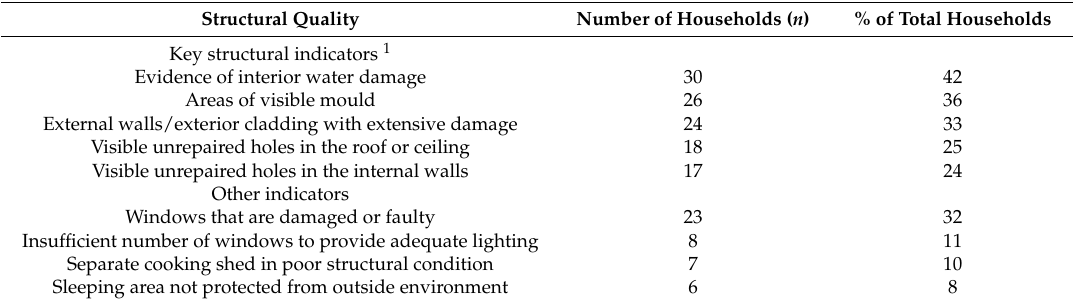
Table 1. The structural quality of the 72 households was assessed to determine the extent of damage and weather tightness to provide shelter and security for the